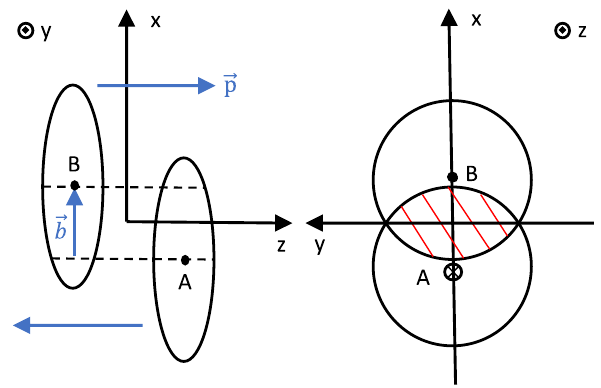
Fig. 1 Sideview(leftpanel)andtopview(rightpanel)onanon-central heavy-ion collision